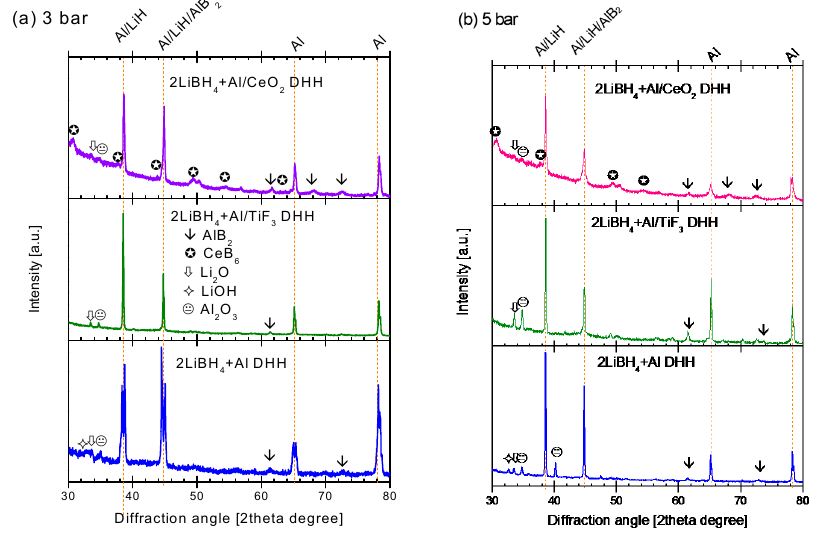
Figure 6. X-ray diffraction patterns of dehydrogenated materials. Frame ( a ) after dehydrogenation at 3 bar initial hydrogen pressure; Frame ( b ) after dehydrogenation at 5 bar initial hydrogen pressure.